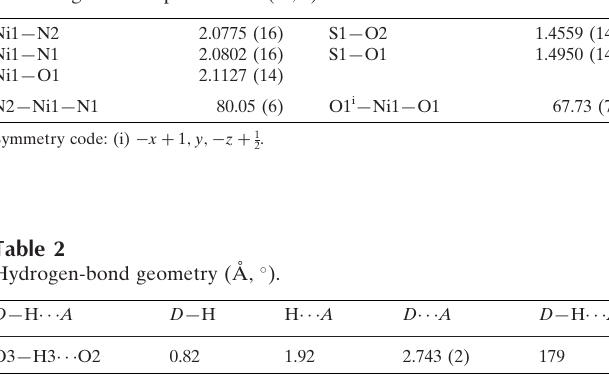
Selected geometric parameters (A˚ , (cid:3) ).